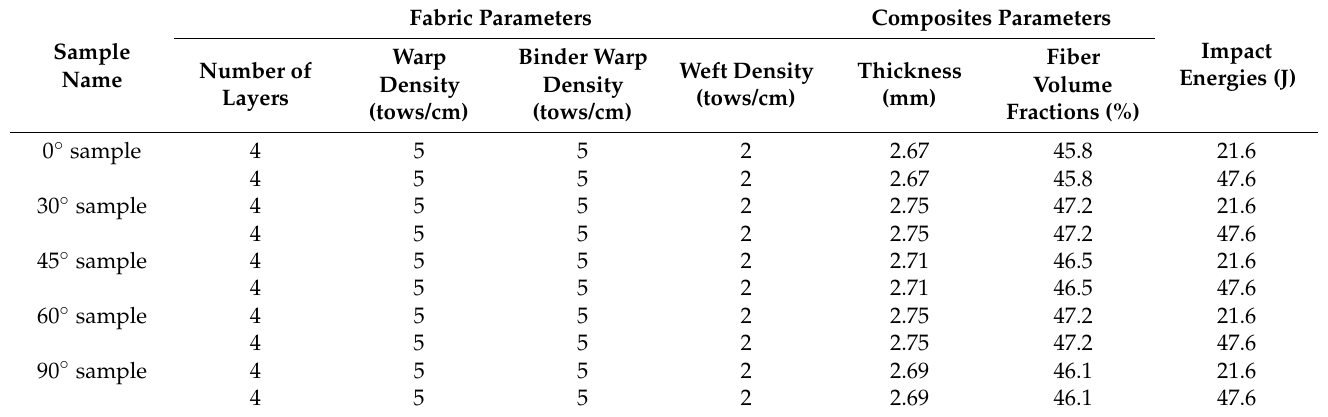
Table 2. Detailed parameters of the 3D angle-interlock woven